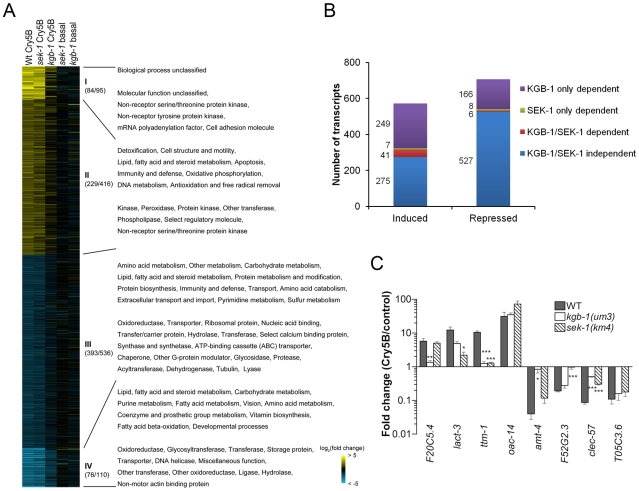
MAPK pathway-dependent transcriptional responses to PFT attack.(A) Heat-map of PFT-responsive genes in microarray experiments. Cry5B responsive genes with ≥2-fold induction (yellow) or repression (blue) relative to non-treated animals are shown. Brighter shades of color correspond to greater fold changes in expression. Different comparisons of treatments are presented at the top of each column. Wt Cry5B: Fold change in Cry5B-treated/non Cry5B-treated glp-4(bn2) animals. sek-1 Cry5B: Fold change in Cry5B-treated/non Cry5B-treated glp-4(bn2);sek-1(km4) animals. kgb-1 Cry5B: Fold change in Cry5B-treated/non Cry5B-treated glp-4(bn2);kgb-1(um3) animals. sek-1 basal: Fold change in glp-4(bn2);sek-1(km4)/glp-4(bn2) animals (both non Cry5B-treated). kgb-1 basal: Fold change in glp-4(bn2);kgb-1(um3)/glp-4(bn2) animals (both non Cry5B-treated). glp-4(bn2) animals lack a functional germline and have otherwise normal response to Cry5B (see Materials and Methods). Use of these animals removes a major tissue from the animals, allowing for intestinal mRNAs to represent a larger portion of the total RNA population. The values in the parenthesis after the slash indicating the number of the genes in each cluster (I and IV strongly up- or down-regulated; II and III moderately up- or down-regulated), with the values before slash denoting the genes with known PANTHER ontologies. The corresponding enriched PANTHER biological processes and molecular functions are shown in each cluster indicated with Roman numerals. For genes involved in immunity/defense processes, we found 14 in cluster II and 22 in cluster III. (B) Summary of number of genes up- and down-regulated by Cry5B, and their dependence upon KGB-1 and SEK-1. (C) qRT-PCR analysis of selected genes from microarray analysis. Results are the average of three experiments and error bars are standard error of the mean. Each gene behaved in the qRT-PCR experiment as was found in the microarray experiment. In this and other figures, * for P≤0.05, ** for P≤0.01 and *** for P≤0.001.